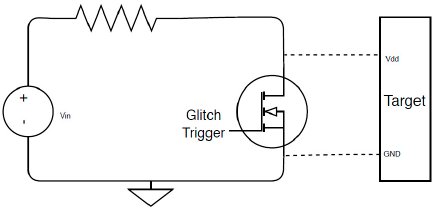
Figure 16. Voltage generator set-up in [19].